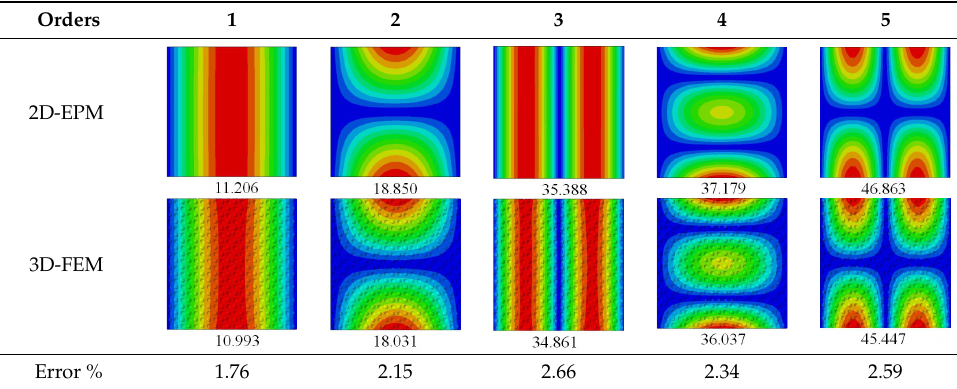
Table 7. Comparison of the first five vibration modes and natural frequencies (Hz) of bidirectional CCCP under the SFSF boundary conditions predicted by different